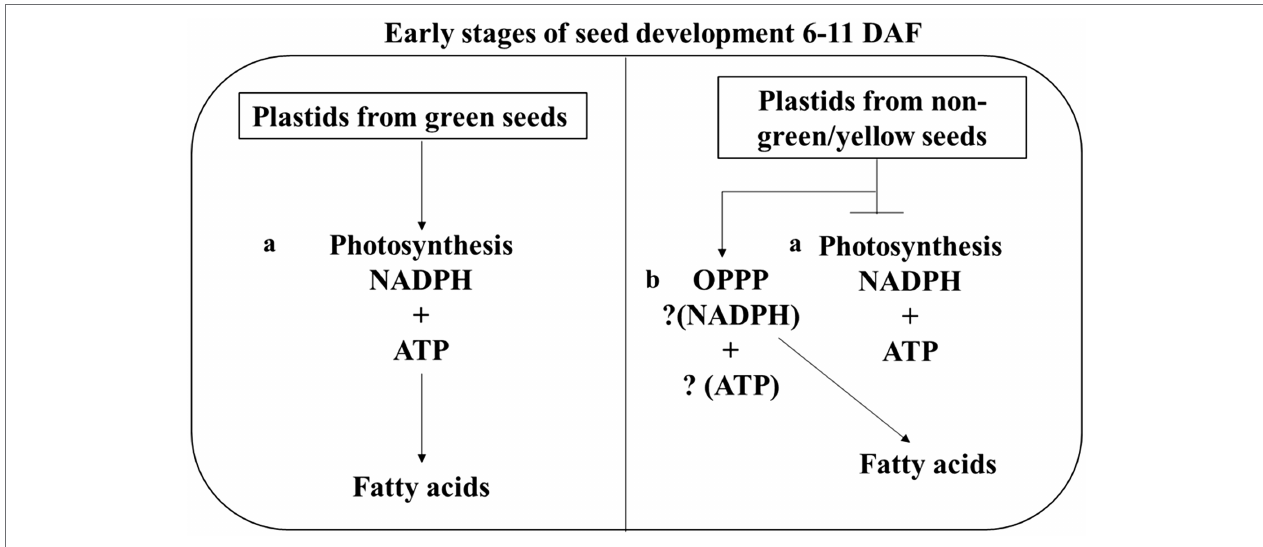
FIGURE 7 | Proposed model of reductant supply for FA biosynthesis seed. This model shows that green developing seeds have two pathways for generating NADPH for FA synthesis during seed development. i.e., (A) Photosynthesis (B) Oxidative pentose phosphate pathway (OPPP). Six to eleven days after flowering were chosen because seeds de-greening starts at 11